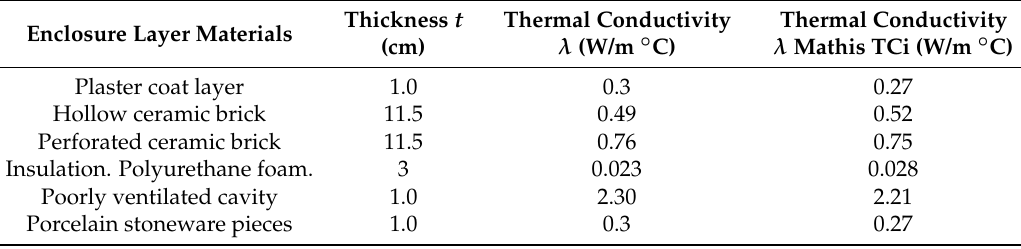
measurements taken using Mathis TCi equipment.